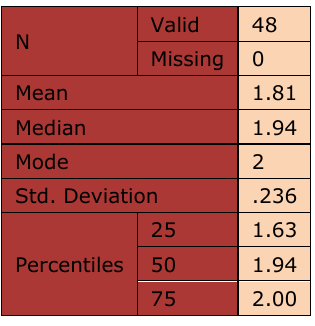
Table 4. Mean, Median, and Mode for All Lean